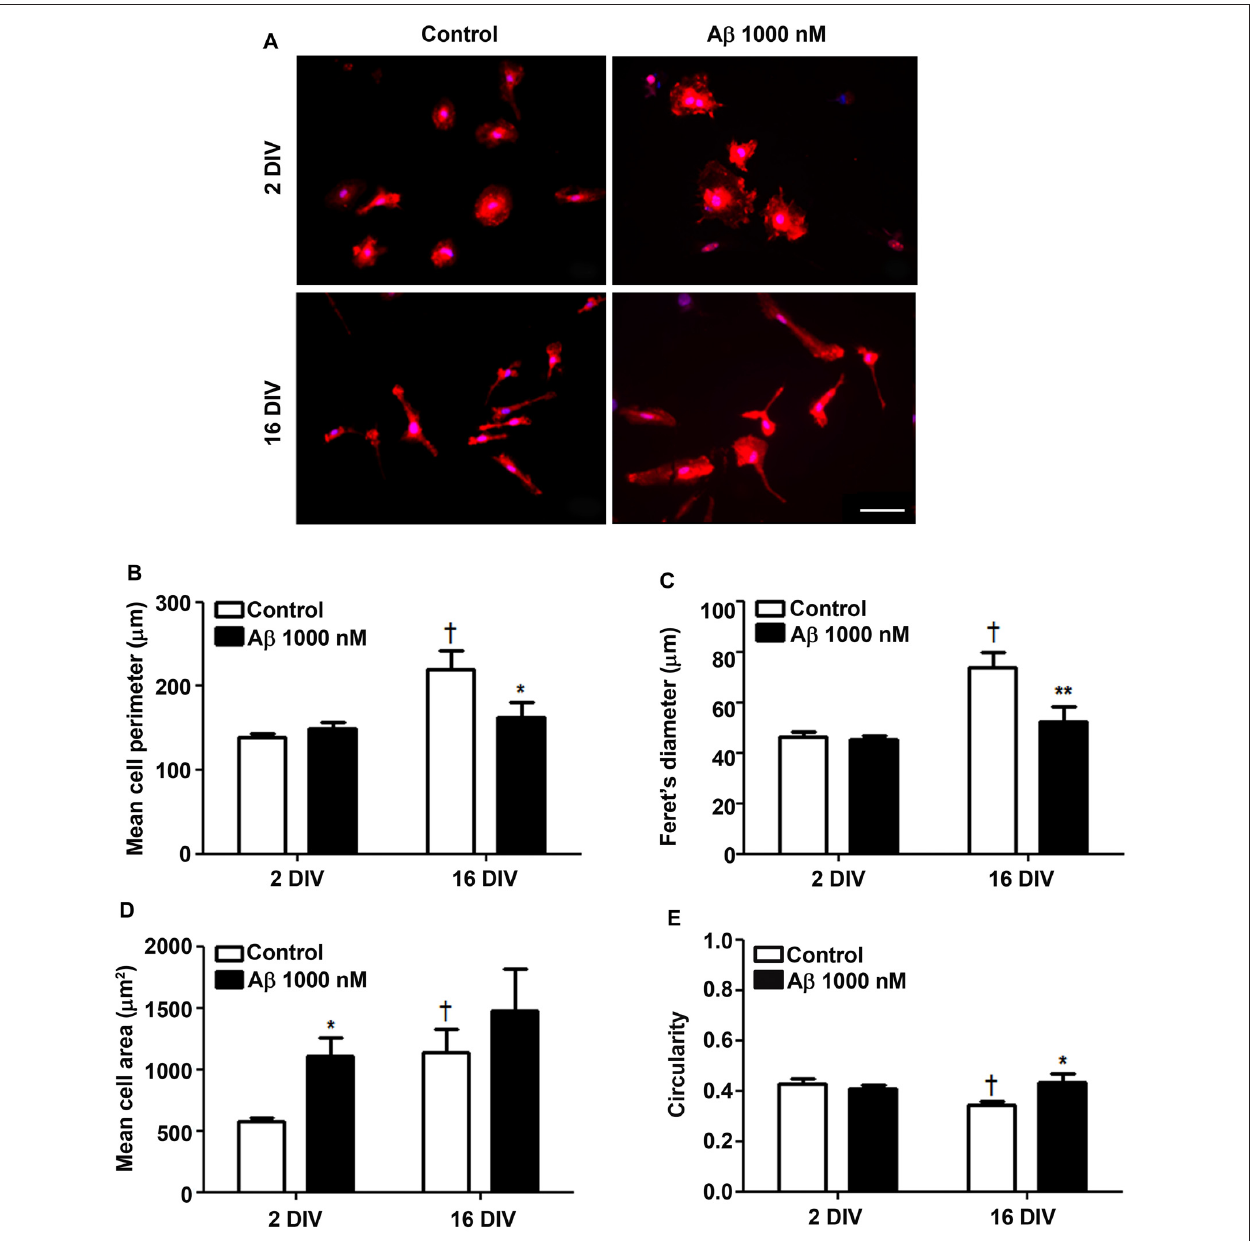
FIGURE 1 | Reactive and aged cultured microglia display soma enlargement and amoeboid morphology after treatment with amyloid- β (A β ) peptide. Microglia that were kept in culture for 2 and 16 days in vitro (DIV) were treated with 1000 nM A β for 24 h. Cells were immunostained for Iba1 and characterized for their morphometric features. (A) Representative images show increased ramification by age, which was counteracted by A β exposure. Microglia perimeter (B) , Feret’s diameter (C) , area (D) and circularity values (E) were measured using ImageJ software and expressed in graph bars as mean ± SEM. Cultures, n = 4 per group. Two-way analysis of variance (ANOVA; Post hoc Bonferroni test): ∗ p < 0.05 and ∗∗ p < 0.01 vs. respective non-treated Control; † p < 0.05 vs. 2 DIV cells; (B) DIV × A β interaction F ( 4.74 ) , p < 0.05; (C) DIV × A β interaction F ( 5.27 ) , p < 0.05; (E) DIV × A β interaction F ( 5.14 ) , p < 0.05. Scale bar equals 50 µ